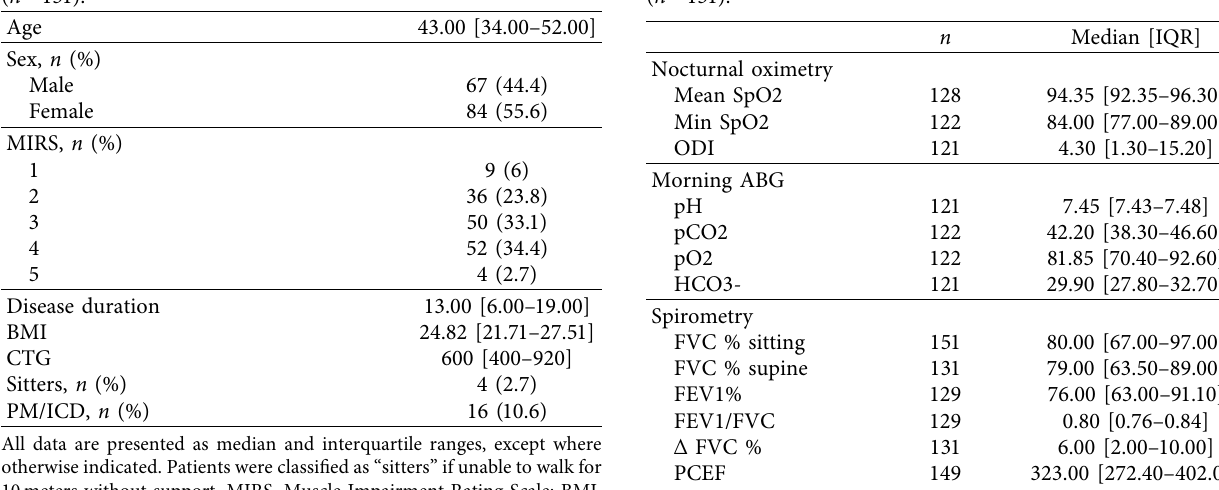
Table 2: Respiratory features of the whole cohort at baseline ( n �